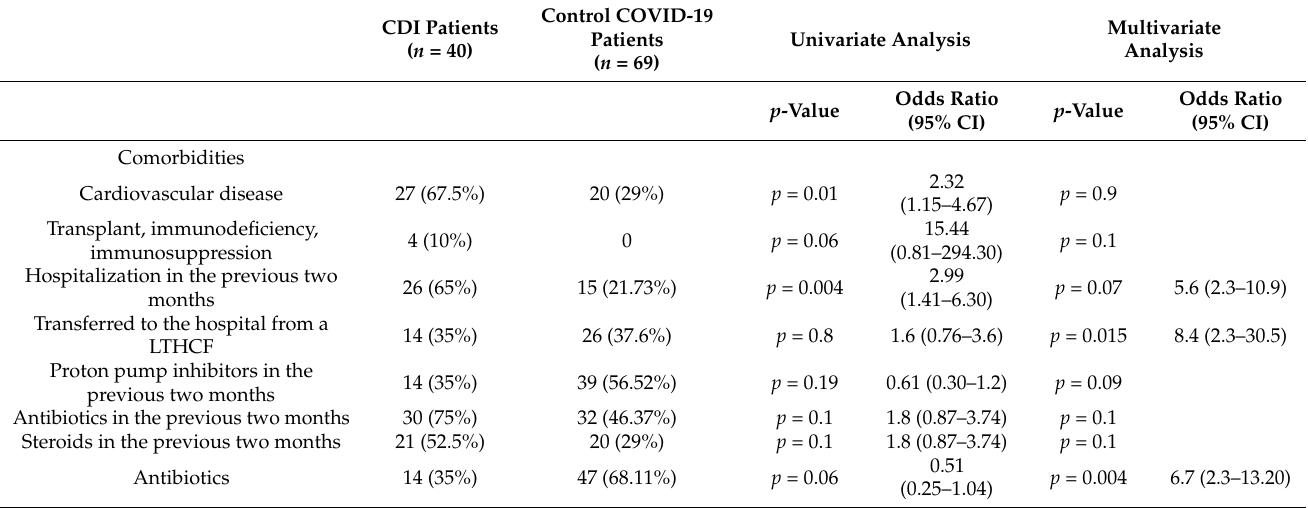
Table 4. Factors associated with likelihood of CDI during COVID-19 infection. Logistic regression